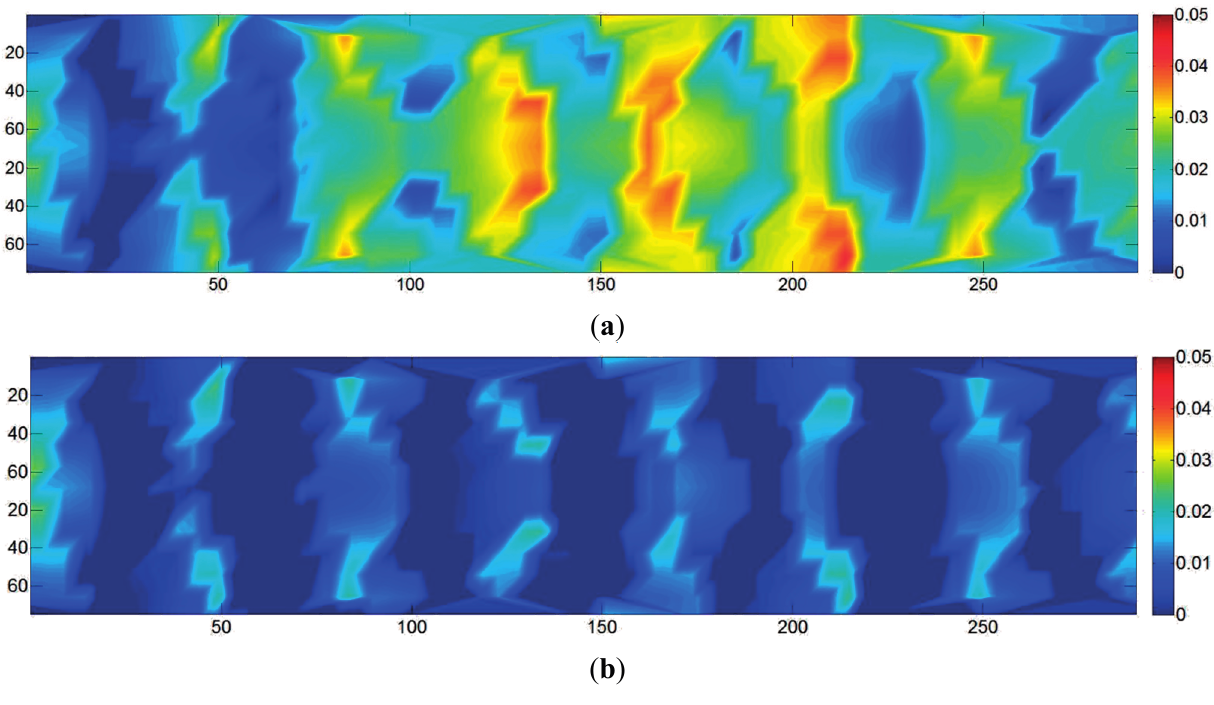
Figure 9. Case 3: standard deviation of the error with 60% overlap along a single strip as a function of the number of GCP: ( a ) Four GCP (Case 3-A); ( b ) eight GCP (Case 3-B).